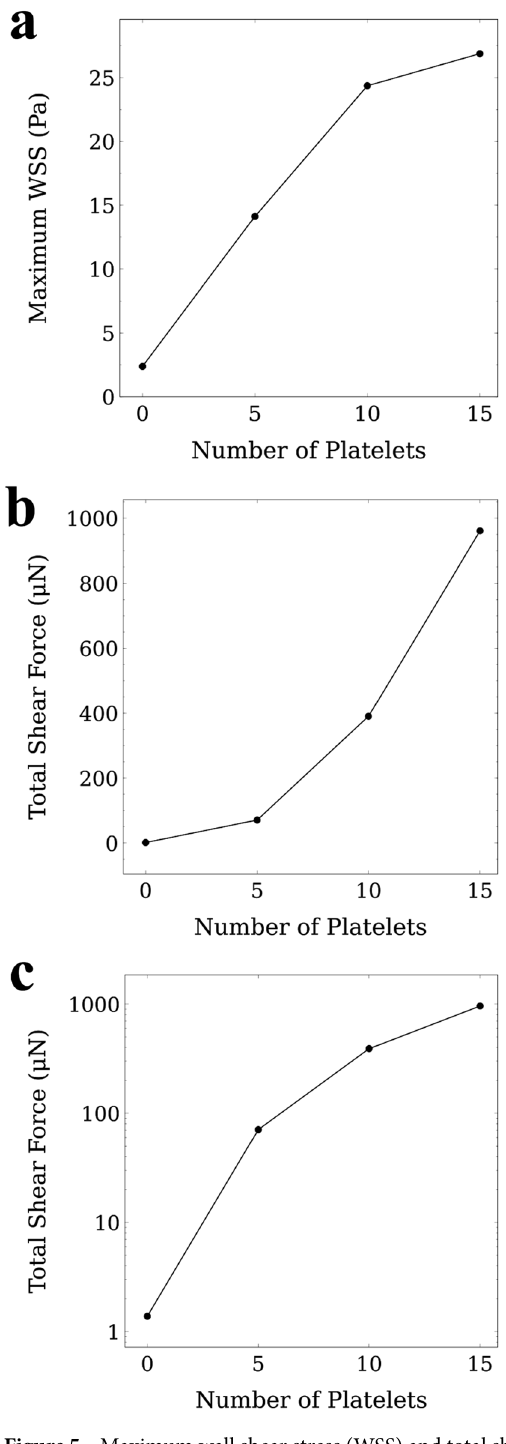
Figure 5. Maximum wall shear stress (WSS) and total shear forces applied to the endothelial cells as functions of numbers of platelets attached to the CTC. ( a ) Maximum WSS applied to the endothelial cells because of the presence of the CTC and the attached platelets in vicinity of the vessel wall. The maximum WSS increases with increasing the number of attached platelets. Because the contact area between the platelets attached to the CTC, and the endothelial cells reaches to its maximum value with a critical number of platelets (here 10 platelets), the maximum WSS remains almost the same after the critical number of attached platelets (10 platelets); ( b ) Total shear force applied to the endothelial cell in the vicinity of the CTC and attached platelets. The total shear force applied to the endothelial cells is calculated by integrating the WSS over the contact area at t = 0.20 s. By increasing the number of attached platelets, the total shear force increases substantially which indicates a higher chance of VEGF expression and CTC extravasation; ( c ) When the total shear force plotted logarithmically, it shows the same trend as the maximum WSS applied to the endothelium ( a